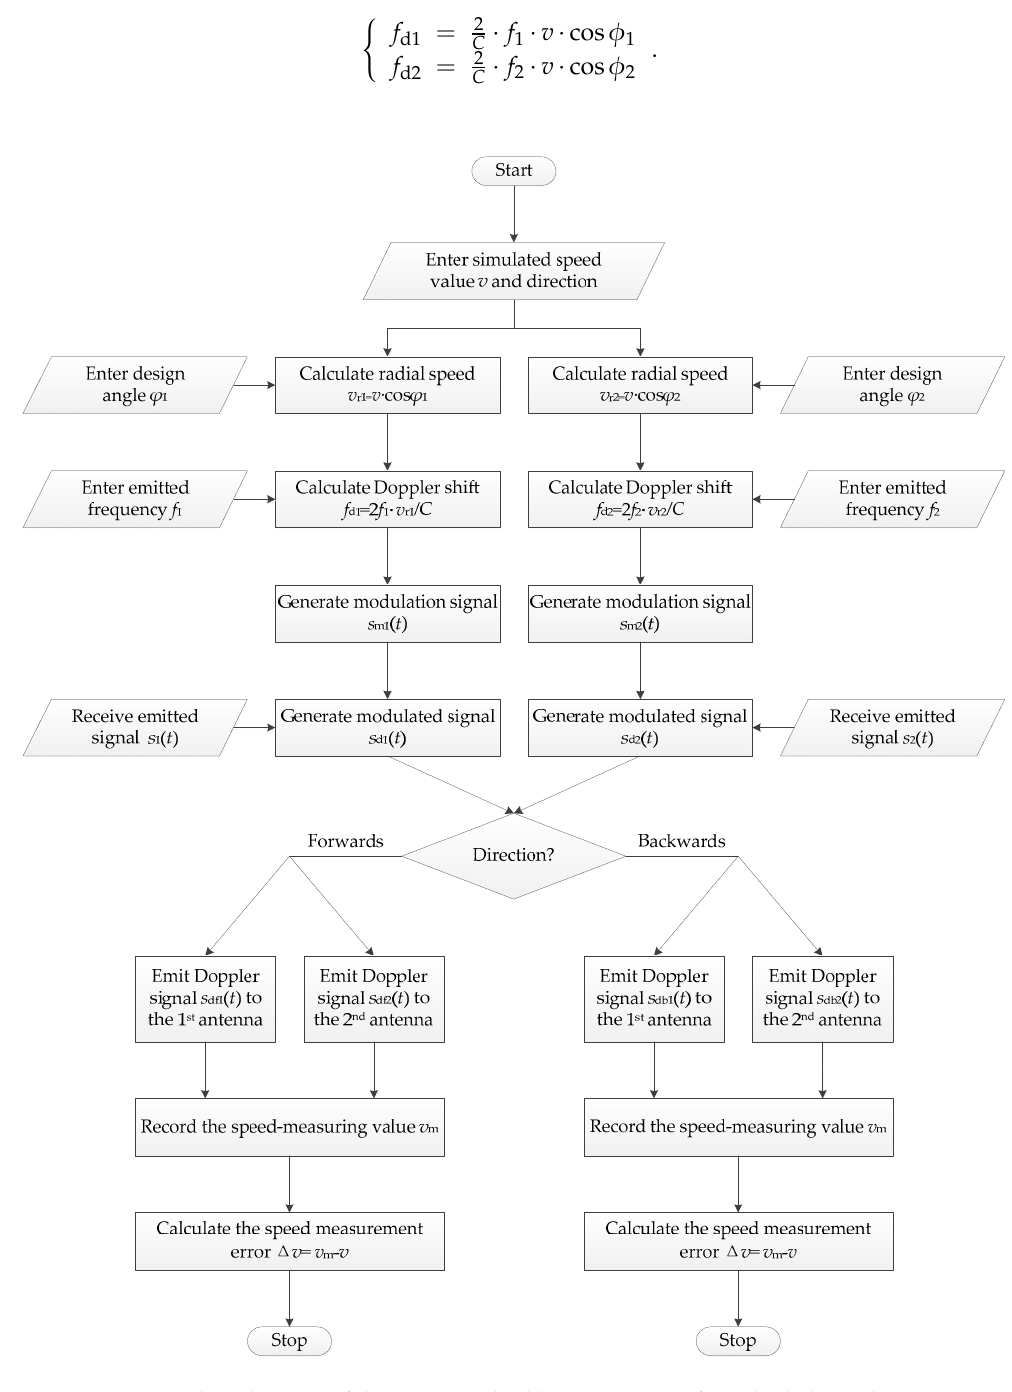
Figure 9. Flow diagram of the new speed calibration process for a dual-channel DRS.